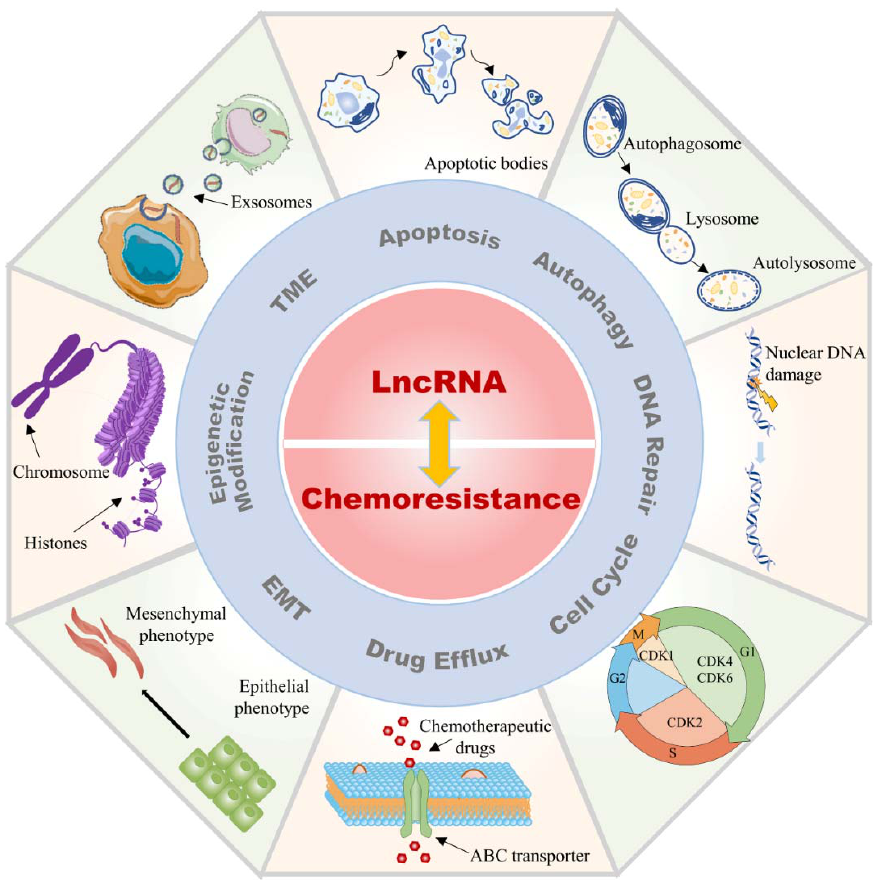
Figure 1. Overview of the relationship between lncRNAs and chemoresistance in this review.